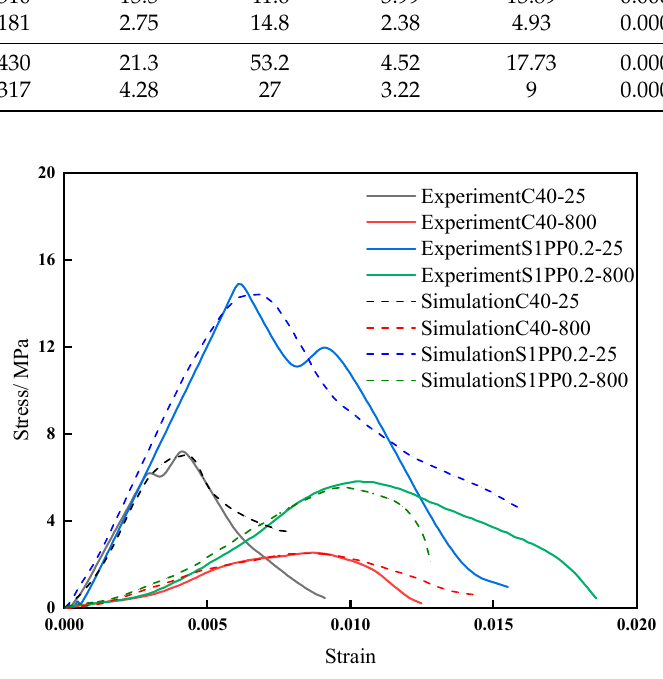
Figure 14. Comparison of experimental and simulated dynamic splitting stress–strain curves.